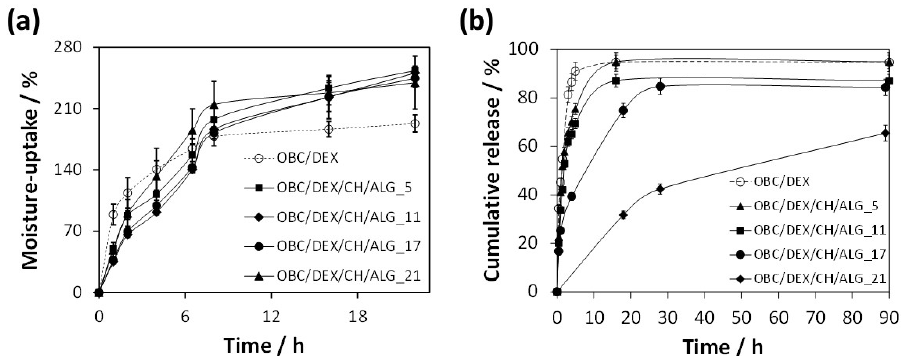
Figure 4. ( a ) Moisture-uptake capacity and ( b ) DEX cumulative release profile of OBC, OBC-loaded with DEX, and multi-layered polysaccharides-based patches.